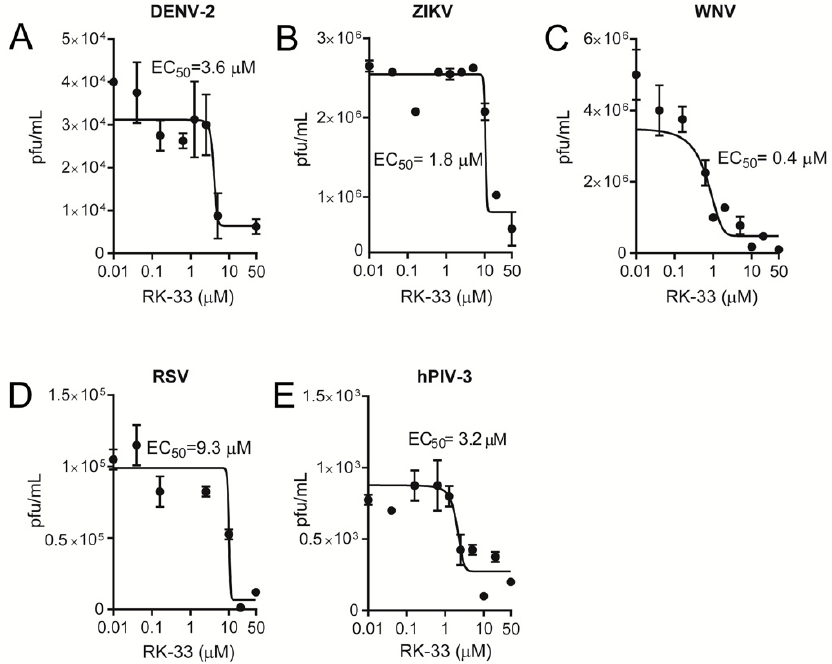
Figure 3. RK-33 is a broad-spectrum inhibitor of infectious virus. Vero cells were infected with ( A ) dengue virus serotype 2 (DENV-2), ( B ) Zika virus (ZIKV), ( C ) West Nile virus (WNV), ( D ) respiratory syncytial virus (RSV) or ( E ) human parainfluenza virus type 3 (hPIV-3) at a multiplicity of infection